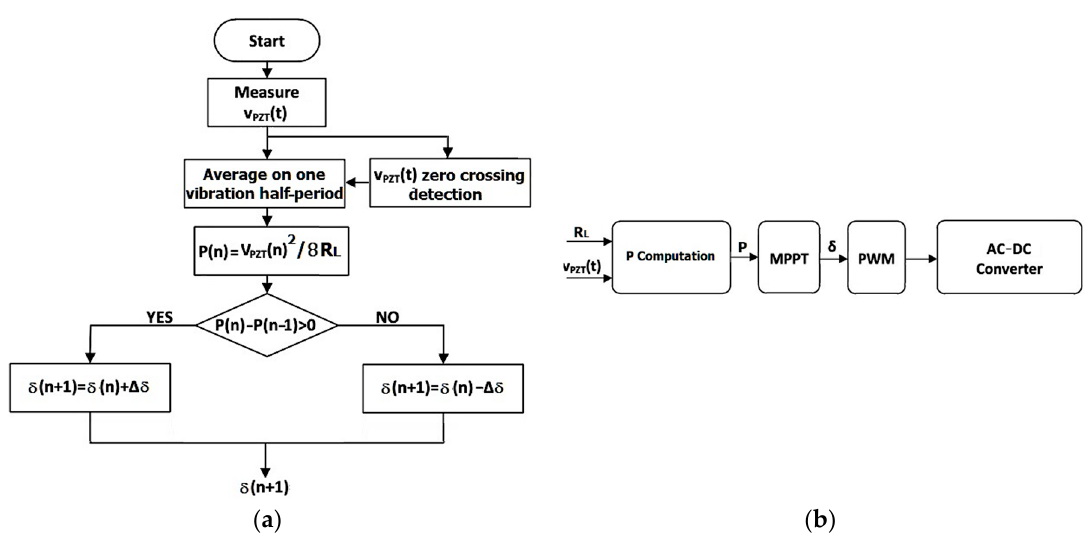
Figure 9. ( a ) Flowchart of the perturb and observe (P&O) maximum power point tracking (MPPT) algorithm and ( b ) converter control system with MPPT.